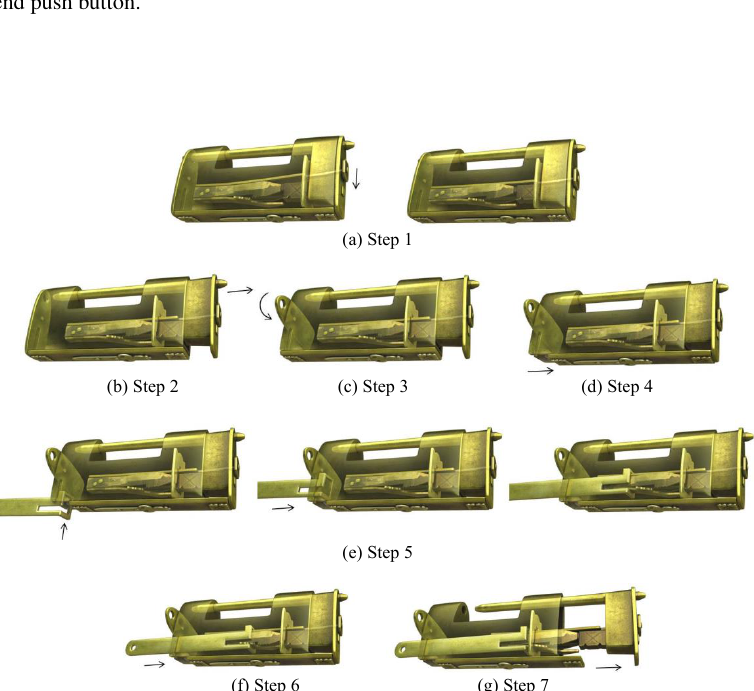
Figure 5. Padlock with an end push button.